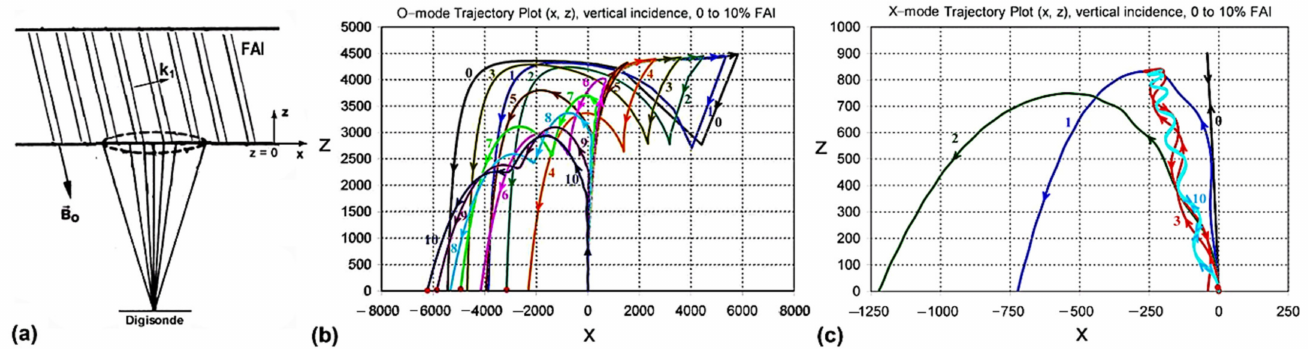
Figure 9. ( a ) Field-aligned density irregularity (FAI) geometry and digisonde beam. ( b ) and ( c ) Vertically incident ray trajectories of ( b ) O-mode ray of 2.8 MHz and ( c ) X-mode ray of 2.8 MHz, in the presence of 0 to 10 % FAI. The axes x and z in ( b ) and ( c ) are normalized to k 0 = ω 0